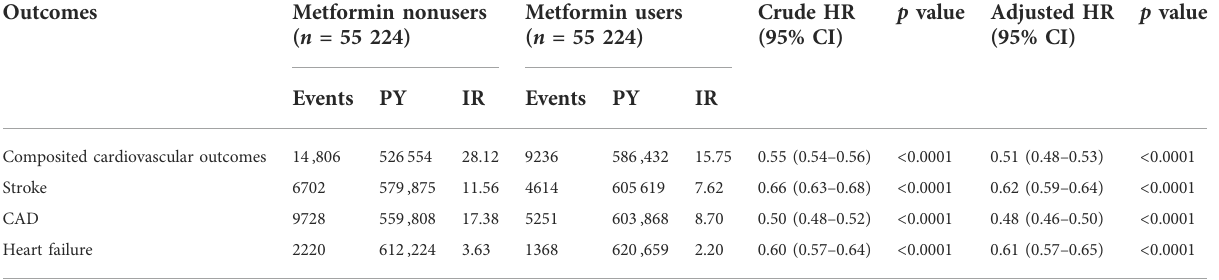
TABLE 2 Hazard ratios and 95% con fi dence intervals of hospitalization cardiovascular outcomes associated with metformin use. Outcomes